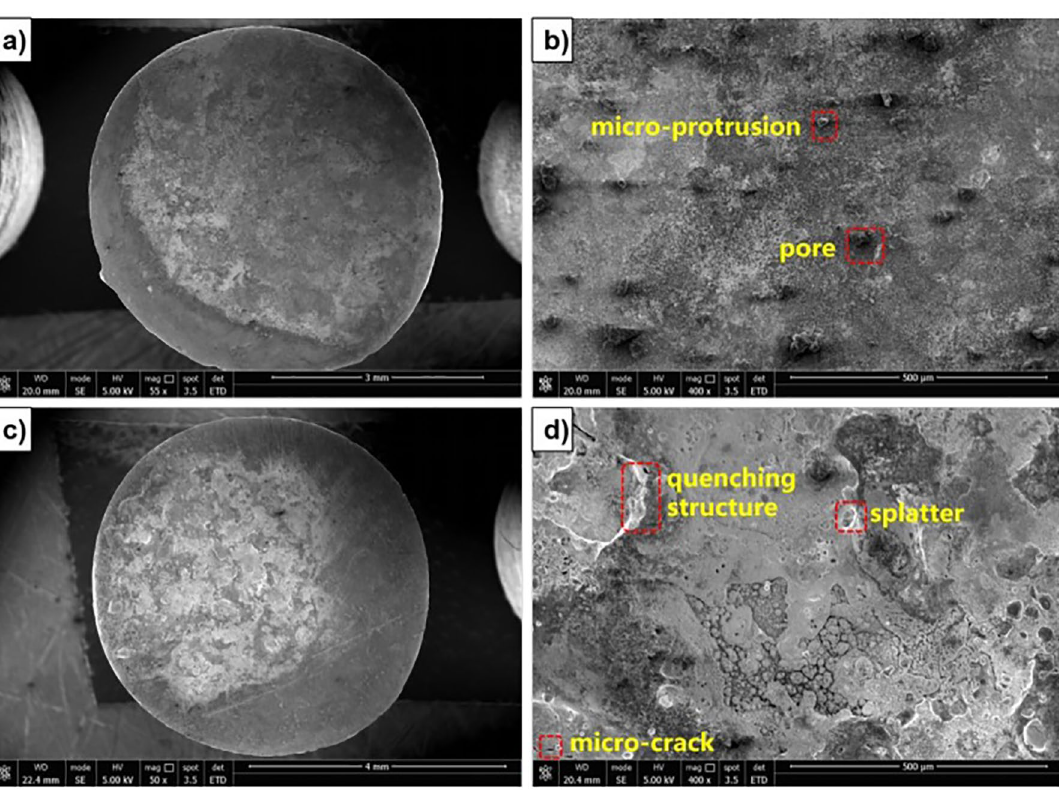
after 10,000 times switching; SEM 2 after 3,000 times 2